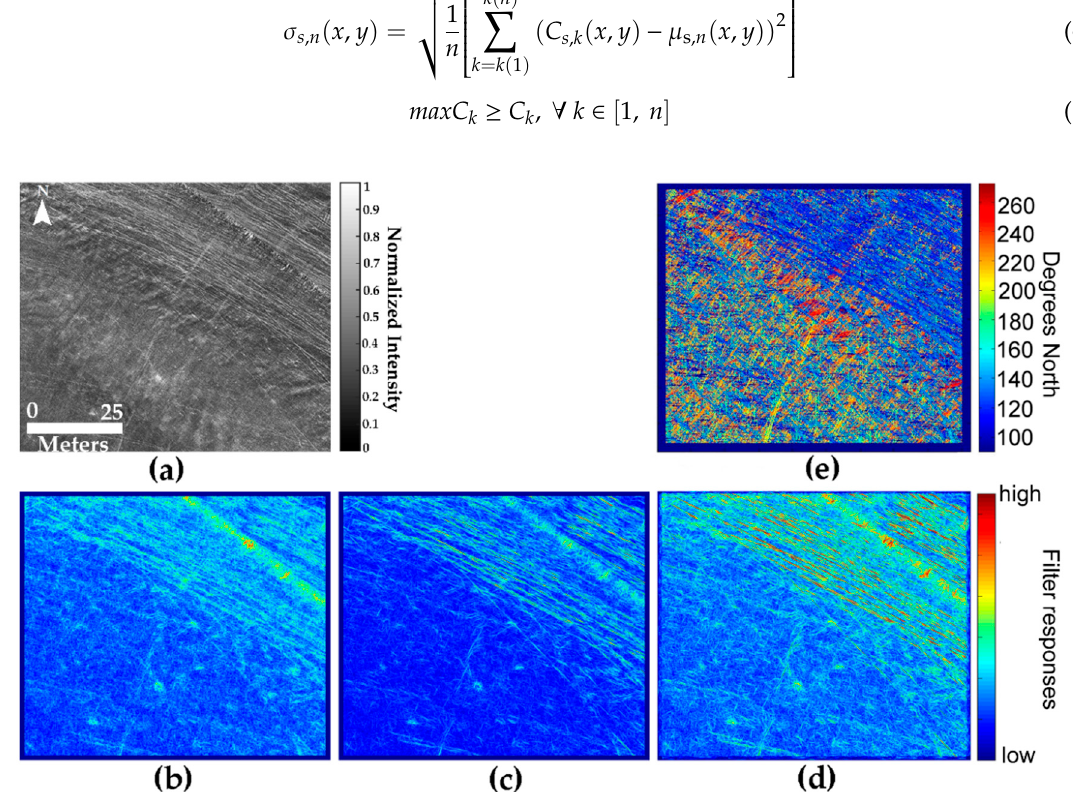
Figure 6. ( a ) The original SSS image, ( b ) and ( c ) the mean ( µ ) and the std ( σ ) values respectively of the filter responses across all directions, ( d ) the Maximum Filter Responses (MFR), ( e ) the directions ( k ) for which the maximum filter responses occur.